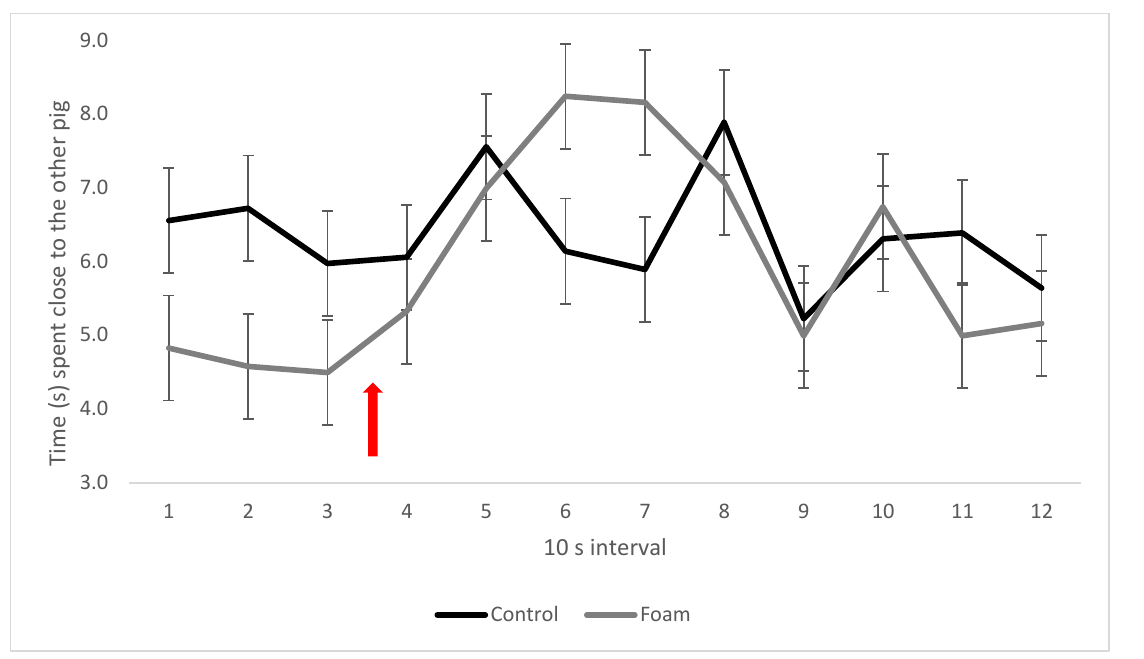
Figure 5. Pig closeness in the control and foam treatments, expressed as mean time (s) spent sharing a floor square with at least one hoof each per 10 s interval. Red arrow indicates time of foam start. Values given are LSM ± SE. Lack of overlap of SE error bars indicates significant pairwise difference ( p < 0.05) between treatments or over time between intervals. Overall p -value for the interaction: p = 0.006.